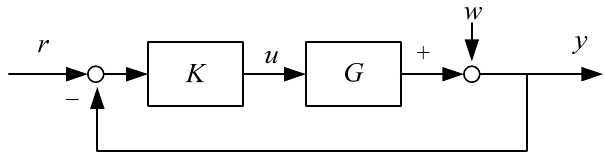
Figure 4. Standard feedback control system.